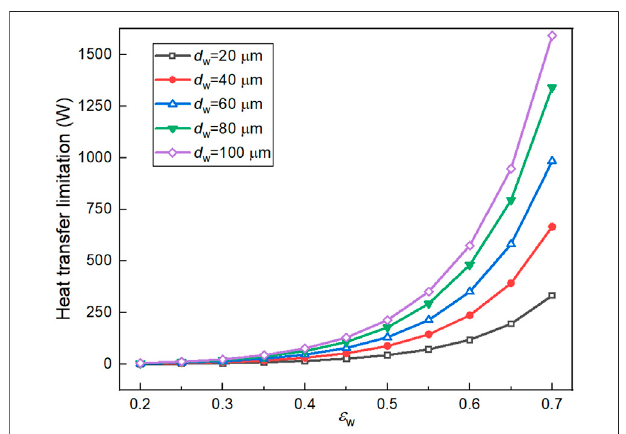
FIGURE 15 | In fl uence of ε w and dw on FHP heat transfer limitation.